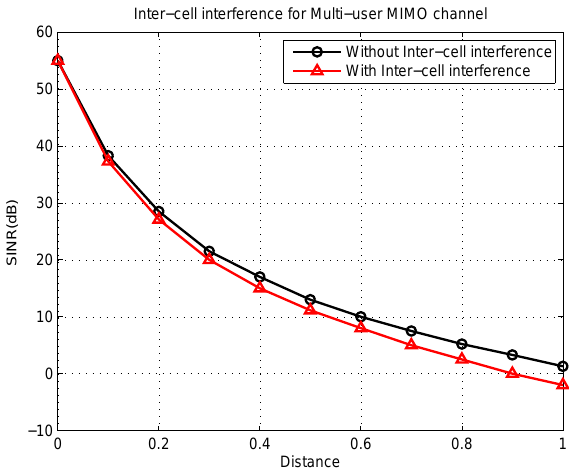
Figure 7. Intercell interference (ICI) for multiuser multiple-input-multiple-output channel.